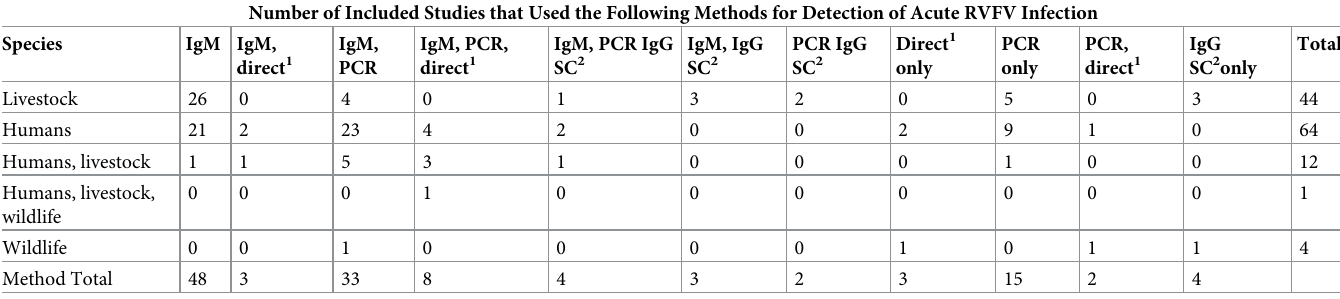
Table 3. Summary of acute diagnostic assays employed in included studies, by species. Number of Included Studies that Used the Following Methods for Detection of Acute RVFV